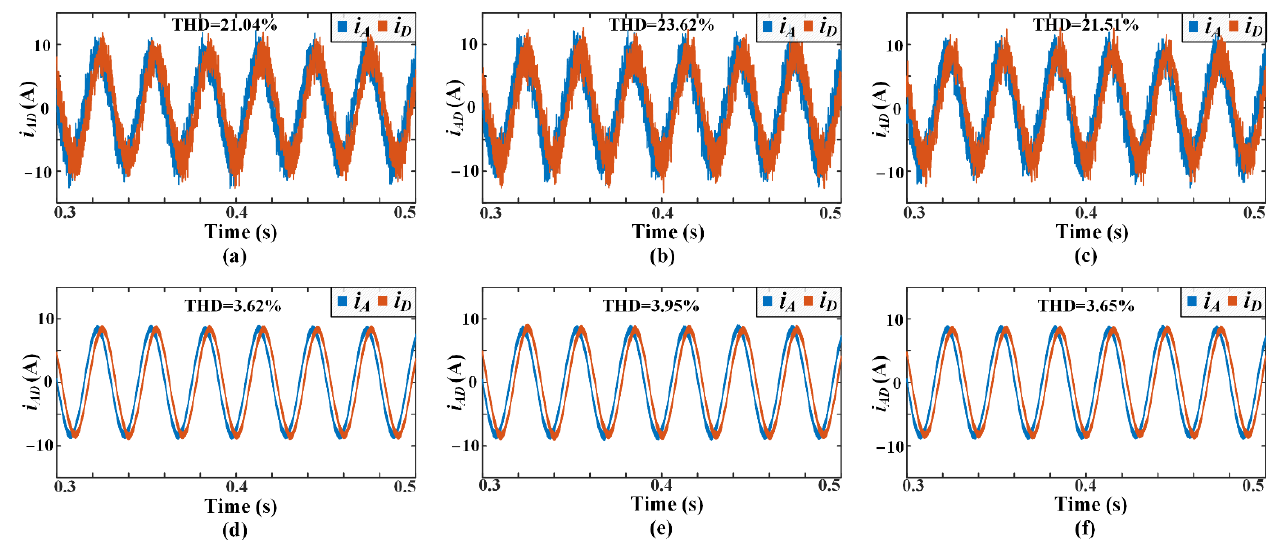
Figure 11. Simulation results of both methods with parameter mismatch. ( a ) VV-MPC without mismatch; ( b ) VV-MPC with 10% inductance mismatch; ( c ) VV-MPC with 10% resistance mismatch; ( d ) MVV-MPC without mismatch; ( e ) MVV-MPC with 10% inductance mismatch; ( f ) MVV-MPC with 10% resistance mismatch.